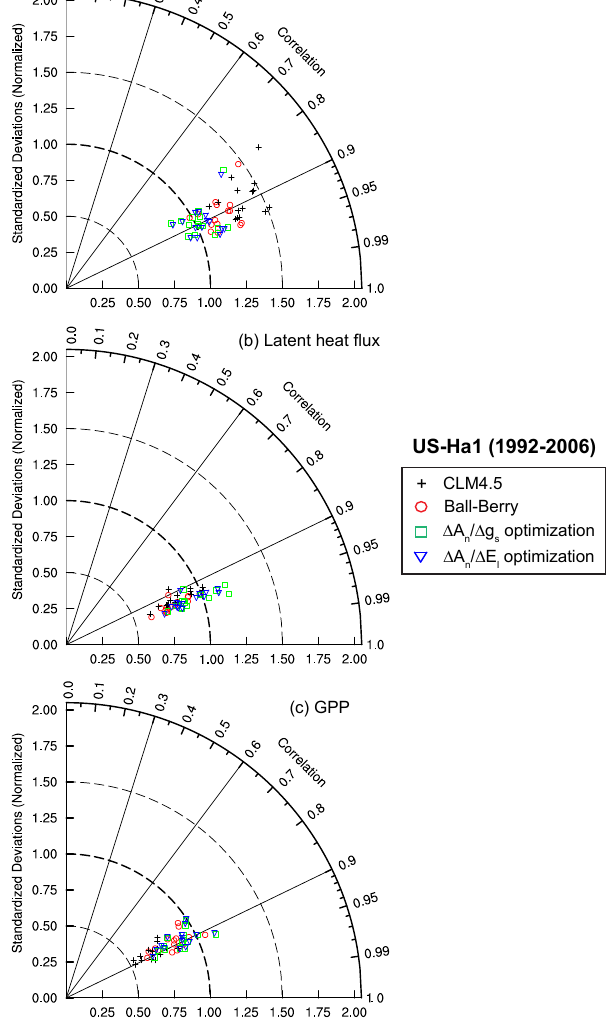
Figure 8 Figure 8. Taylor diagram of (a) sensible heat flux, (b) latent heat